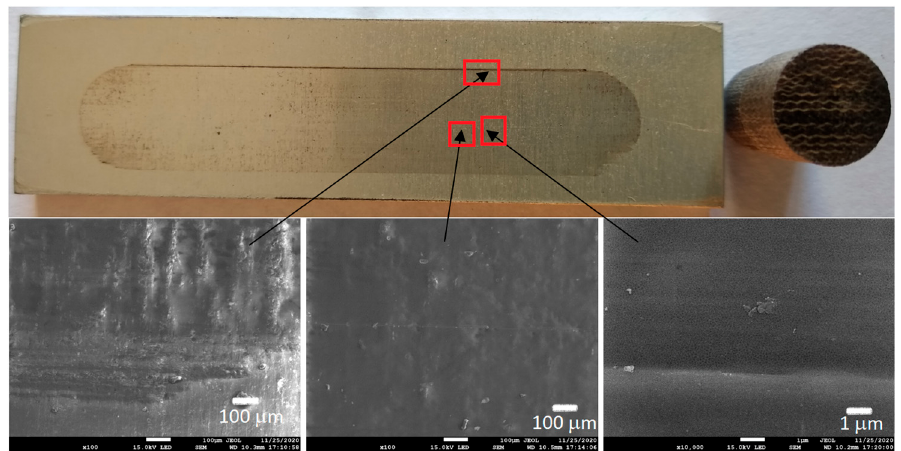
Figure 9. Photographs and SEM micrographs of Al 2 O 3 tribological pairs after a tribological test with PF + cotton + C.